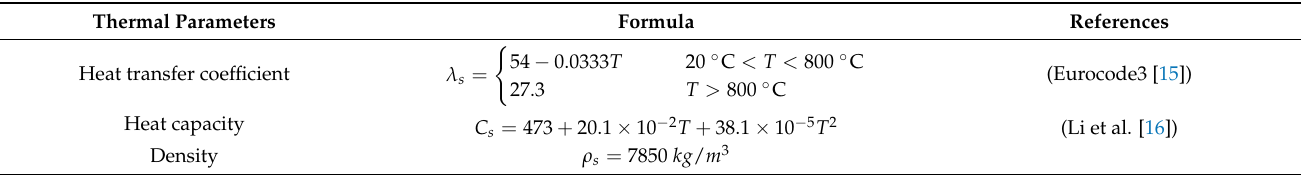
Table 2. Thermal parameters of steel at elevated temperature.